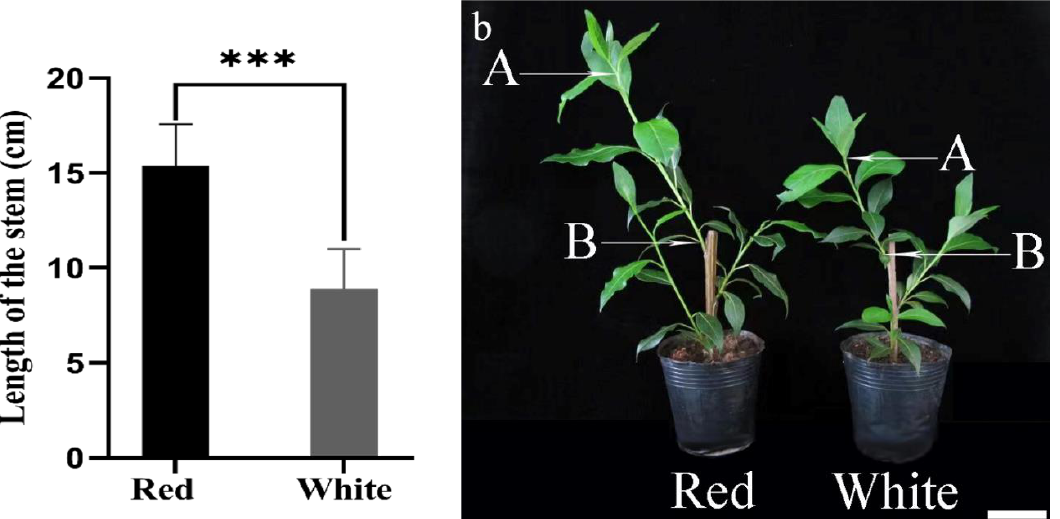
Figure 11. ( a ): Heights of the stems after 14 days of growth under white and red light. ( b ): Plants grown for 14 days under white and red light. ***: Significant correlation at the 0.001 probability level. Error bars indicate the SD of three independent biological and technical replicates. Bar = 5 cm.